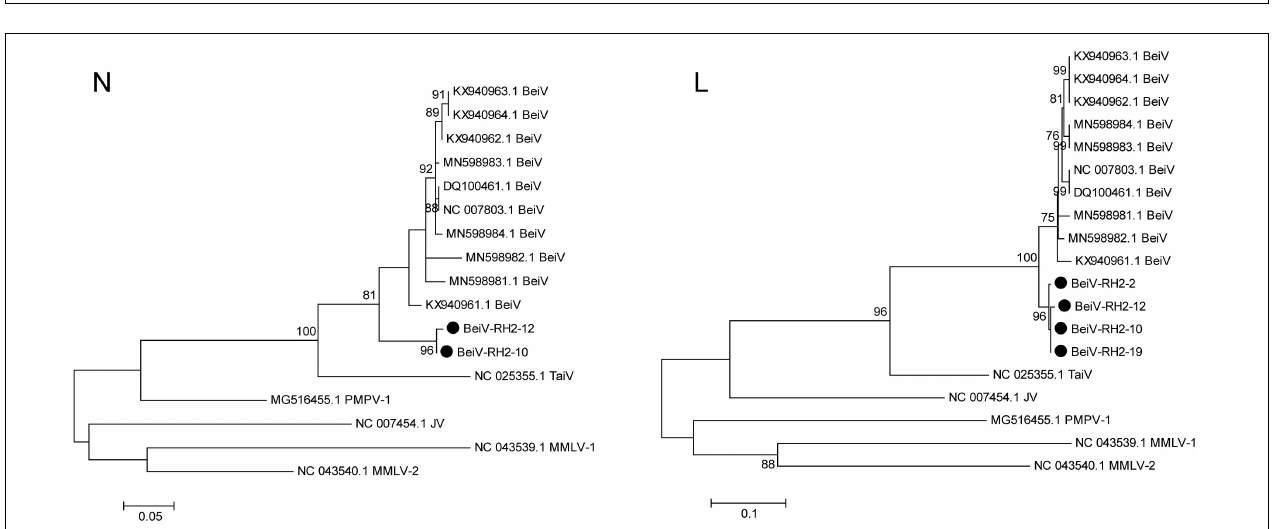
FIGURE 5 | Maximum likelihood phylogenetic tree constructed based on the M, L, and S segments of Hantavirus. Seoul virus (SEOV), Hantaan virus (HTNV), Sin Nombre virus (SNV), Black Creek Canal virus (BBCV), Bayou virus (BAYV), Andes virus (ANDV), Tula virus (TULV), Prospect Hill virus (PHV), Puumala virus (PUUV), New York virus (NYV), Thailand virus (THAIV), Dobrava virus (DOBV), Andes virus (ANV), and Thottapalayam virus (TPMV).